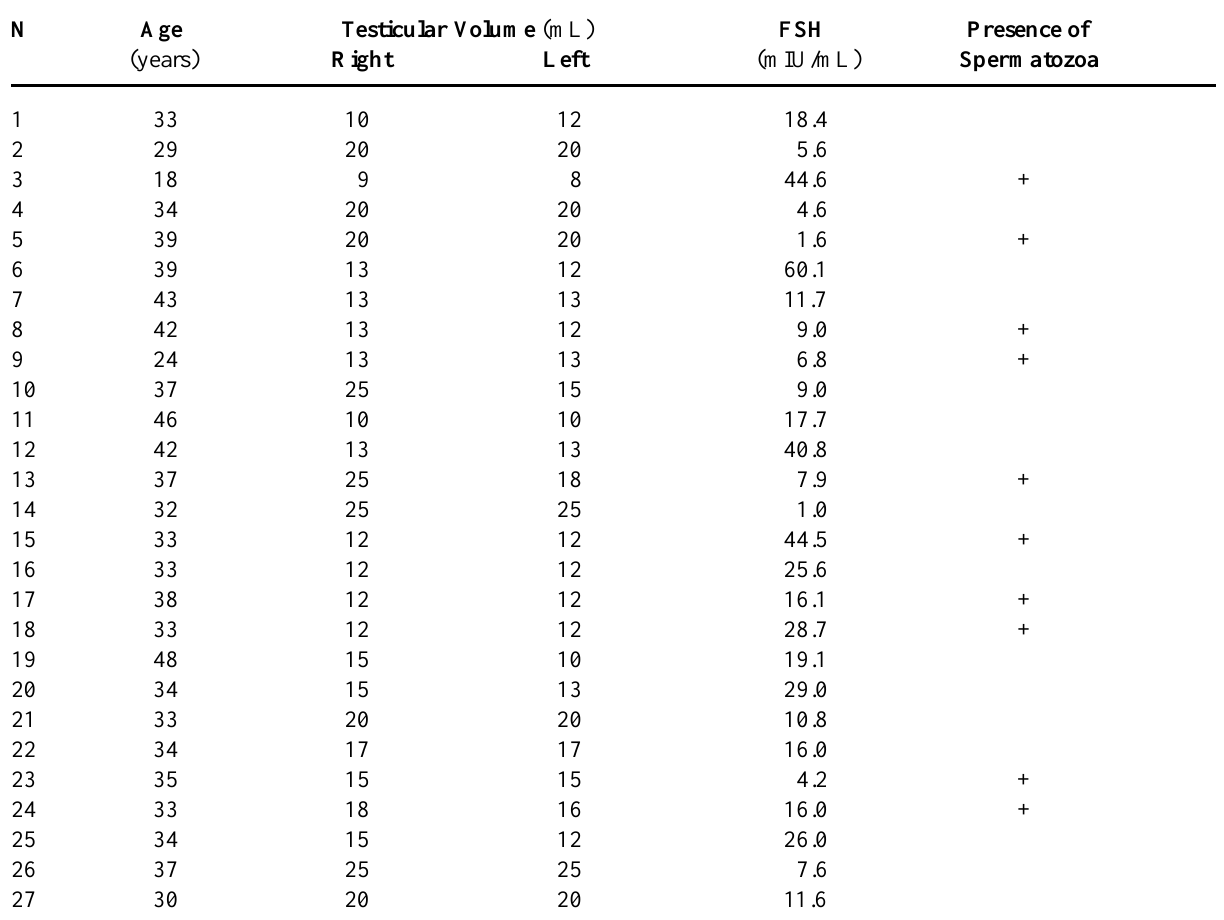
Table 1 – Clinical and laboratorial data from the 27 patients under study.